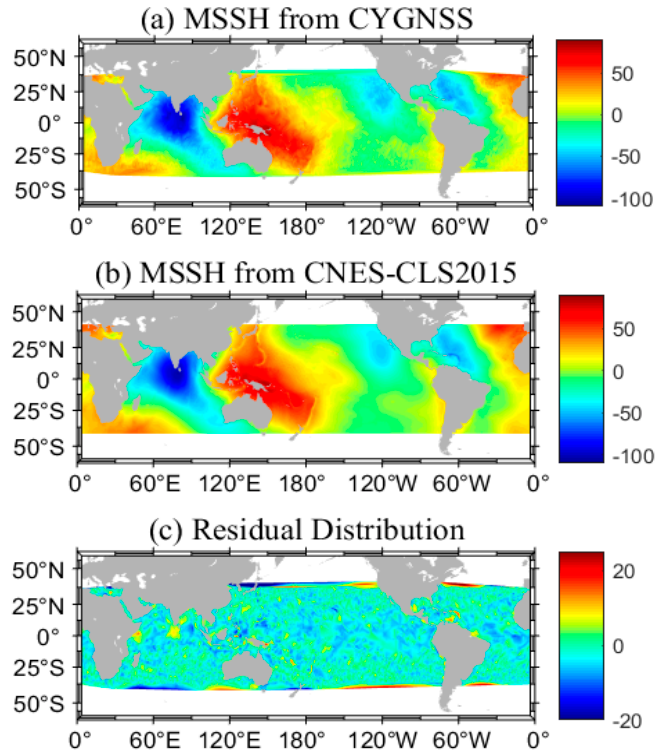
Figure 5. ( a ) Global mean sea surface elevation map estimated by the Cyclone Global Navigation Satellite System (CYGNSS); ( b ) using the CNES_CLS2015 model to obtain the average sea surface height distribution of monitored sea areas; ( c ) the distribution of residual between ( a , b ). Remote Sens. 2020 , 12 , 356